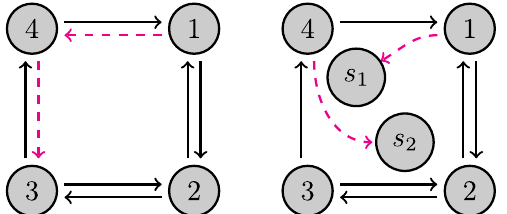
FIG. 16. Left diagram: example of a four-states network with visible transitions L ¼ f 1 → 4 ; 4 → 3 g (dashed magenta line). Right diagram: network of the extended state space, where visible transitions are redirected to auxiliary absorbing states s 1 and s 2